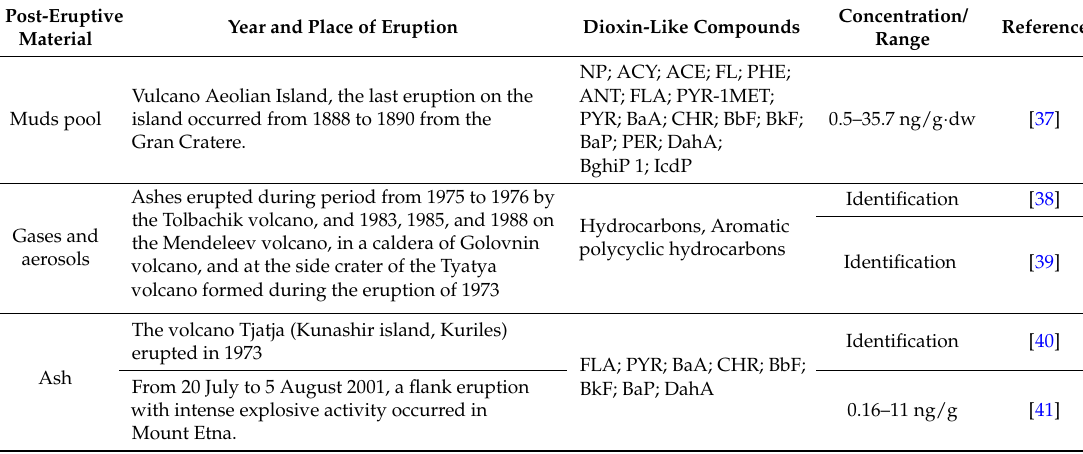
Table 3. Dioxin-like compounds in post-eruptive